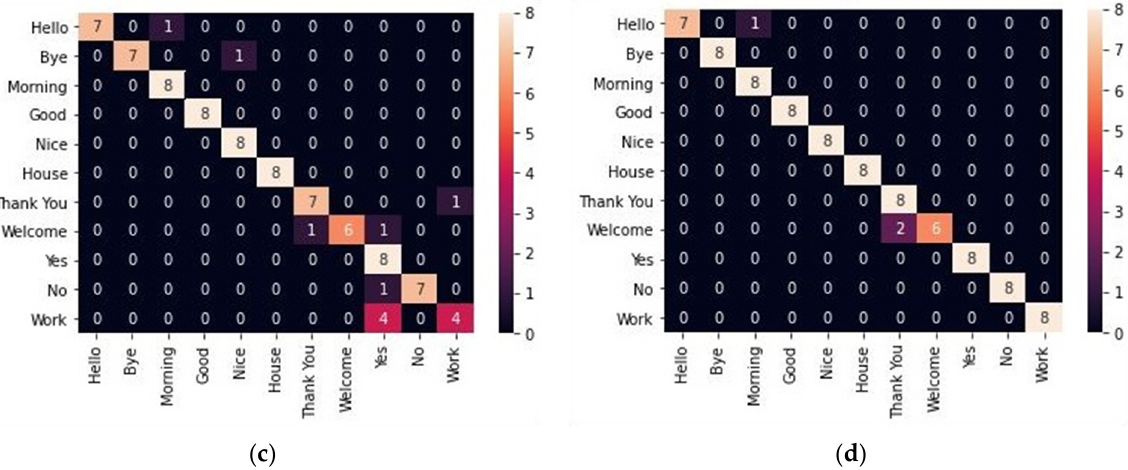
Figure 5. Validation Confusion matrix for all four combinations with fold value 1, the rest of the parameters are the same as in the training: ( a ) GRU-GRU; ( b ) LSTM-LSTM; ( c ) GRU-LSTM; ( d ) LSTM-GRU.